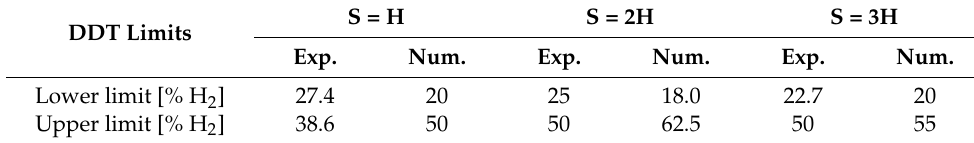
Table 2. DDT limits measured experimentally [31] and obtained numerically (this work).